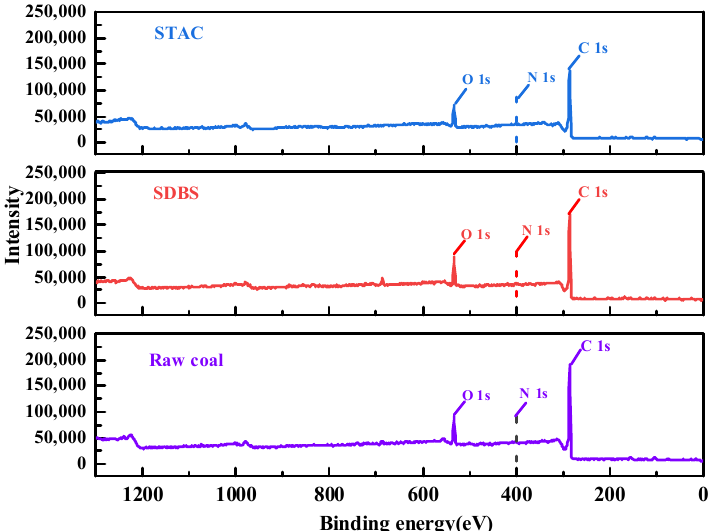
Figure 5. XPS spectrum of anthracite raw coal and adsorption of surfactant.